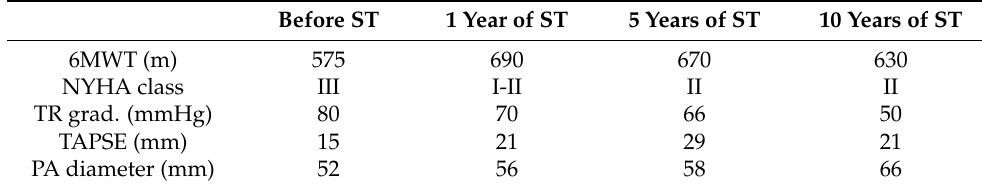
Table 2. Functional and echocardiographic parameters during the follow-up period (Patient 1). Before ST